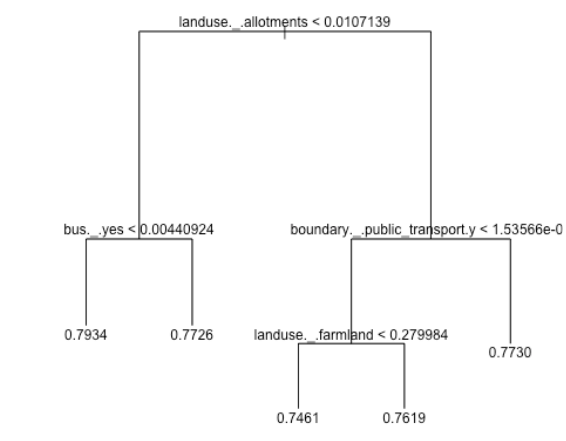
Figure 3. Pruned tree age